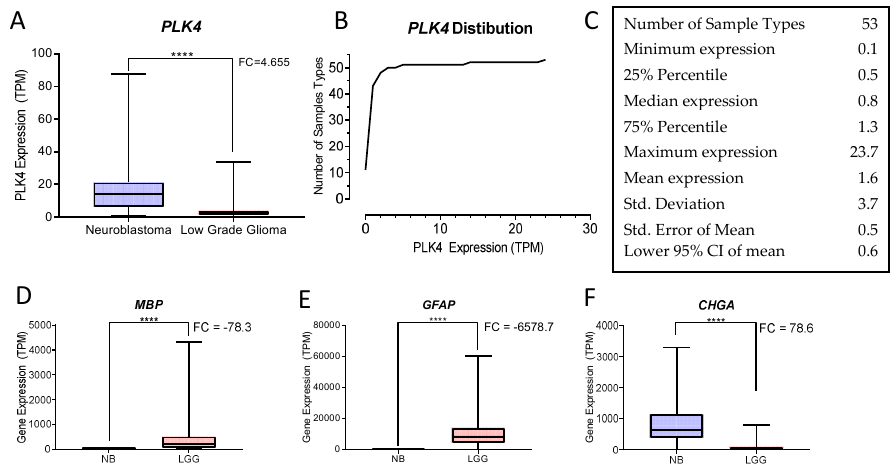
Figure 4. GDC Expression Analysis of NB and LGG. ( A ) PLK4 expression in NB and LGG shows significant overexpression in neuroblastoma (NB) when compared with low grade gliomas (LGG) (**** p < 0.0001, unpaired t -test). ( B ) Relative frequency distribution of PLK4 expression among samples described in Table 2: NB (TARGET n = 153), LGG (TCGA n = 508) and 51 normal human tissue sample types (GTEx Portal). ( C ) Descriptive statistics of PLK4 expression in the cohort of tissue sample types (GraphPad). ( D , E ) The glioma markers MBP and GFAP respectively, show significant overexpression in LGG compared to NB (**** p < 0.0001, unpaired t -test). ( F ) The NB maker CHGA , shows overexpression in NB compared to LGG (**** p < 0.0001, unpaired t -test). All graphs were generated and statistics calculated using PRISM (GraphPad Software, Inc.). Table 2. GDC and GTEx Portal Gene Expression Data. RNAseqV2 data extracted from the GDC database (Neuroblastoma and Low Grade Glioma) and GTEx Portal (51 normal human tissue samples). Genes displayed are: PLK4 (Polo-like kinase 4), CHGA (Chromogranin A), MBP (Myelin basic protein) and GFAP (Glial fibrillary acidic protein). Expression is represented as median TPM (Transcripts per million) values.